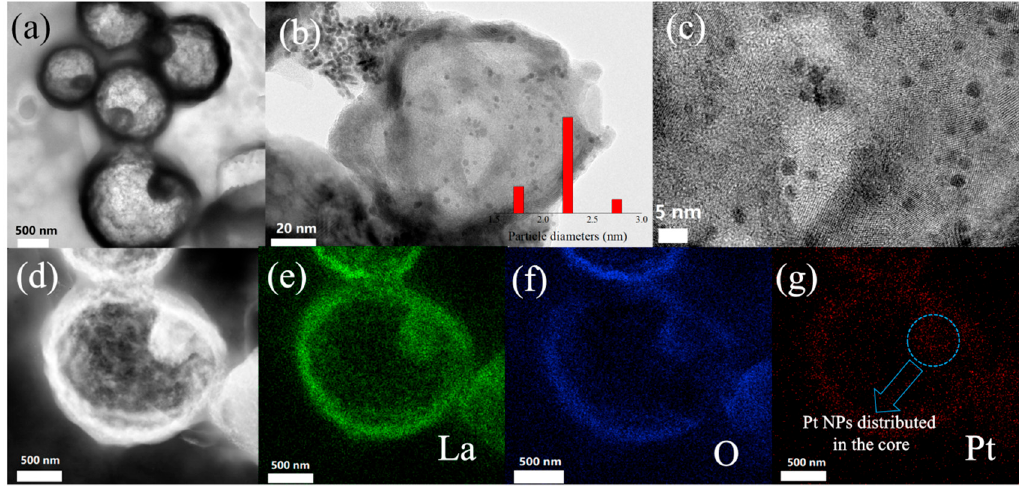
Figure 2. ( a ) TEM and ( b , c ) High-resolution TEM images of S1. ( d ) HAADF-STEM images of S1 and corresponding EDS elemental mapping images of ( e ) La, ( f ) O and ( g ) Pt, respectively.